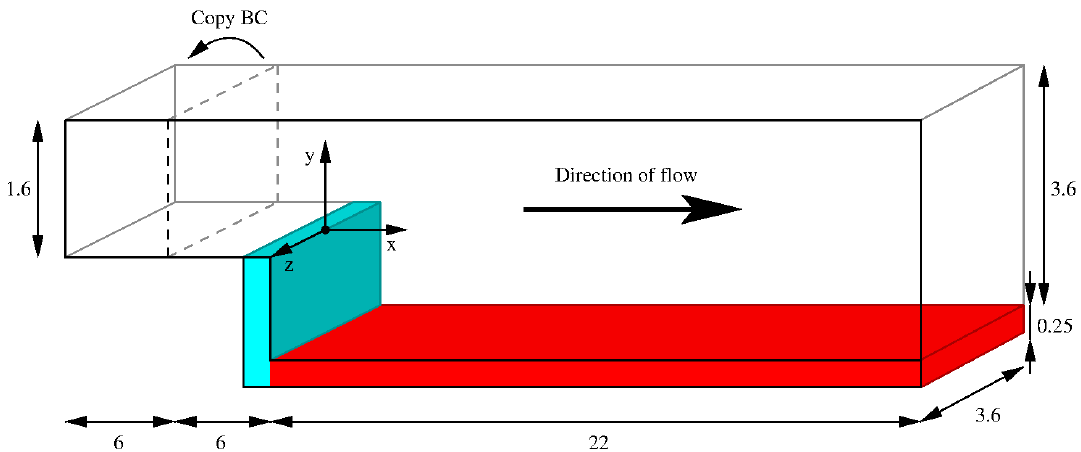
Figure 1. Sketch of backward-facing step (BFS) domain used in the direct numerical simulation (DNS). Flow flows from the narrow end towards the wide end. The blue and red coloured blocks are solid walls. Except for the inflow and outflow, all other surfaces are no-slip velocity boundary conditions.